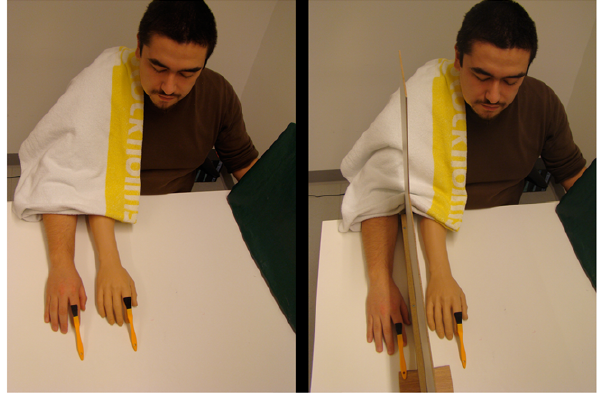
Figure 3. Supernumerary hand illusion vs. traditional rubber hand illusion. Set-up used in experiment 5 to elicit the supernumerary hand illusion (left panel) and the traditional rubber hand illusion (right panel). Note that the only difference was the screen occluding vision of the real right hand in the latter condition.